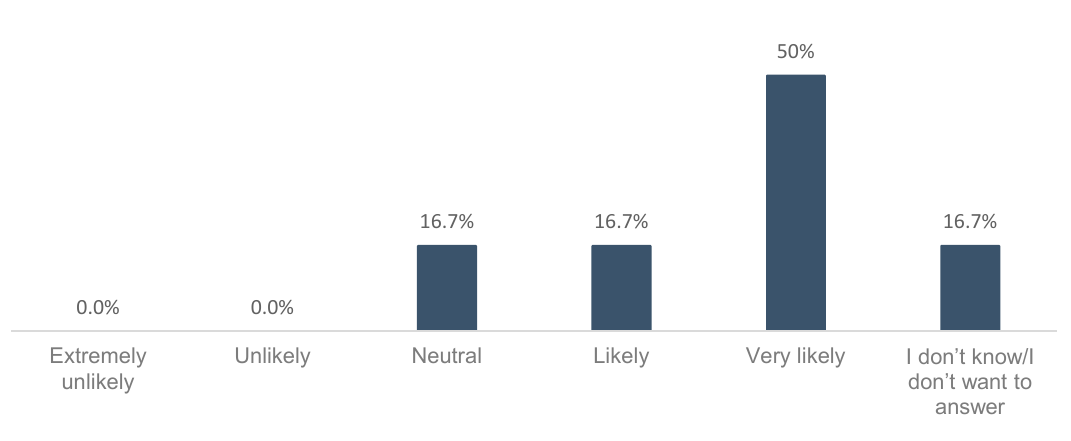
Figure 17. Regulatory reporting.